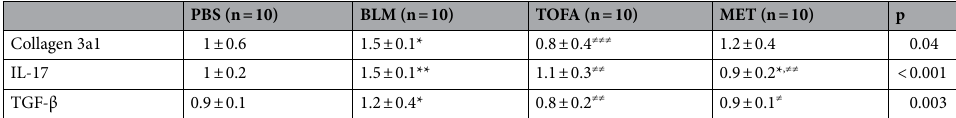
PBS (n = 10) BLM (n = 10) TOFA (n = 10) MET (n = 10) 1 ± 0.6